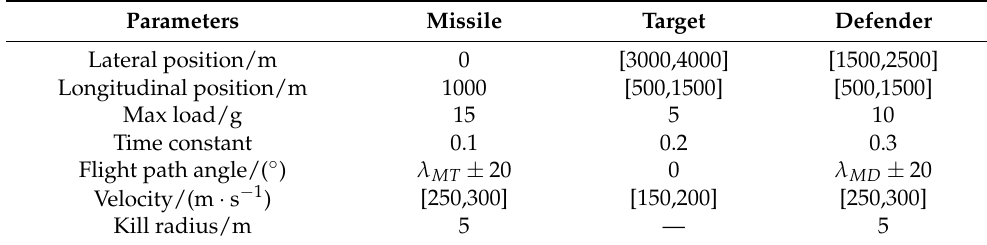
Table 2. Initial parameters for training.